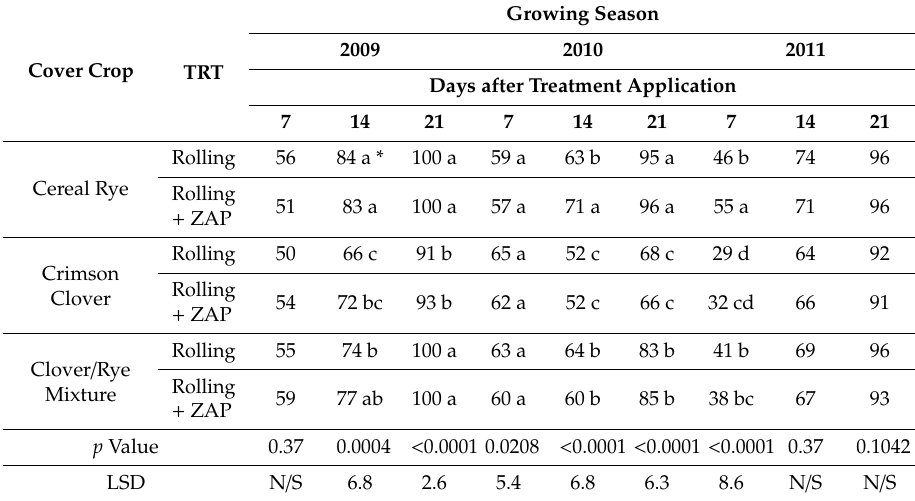
Table 5. Cover crop termination rates during 2009, 2010, and 2011 growing